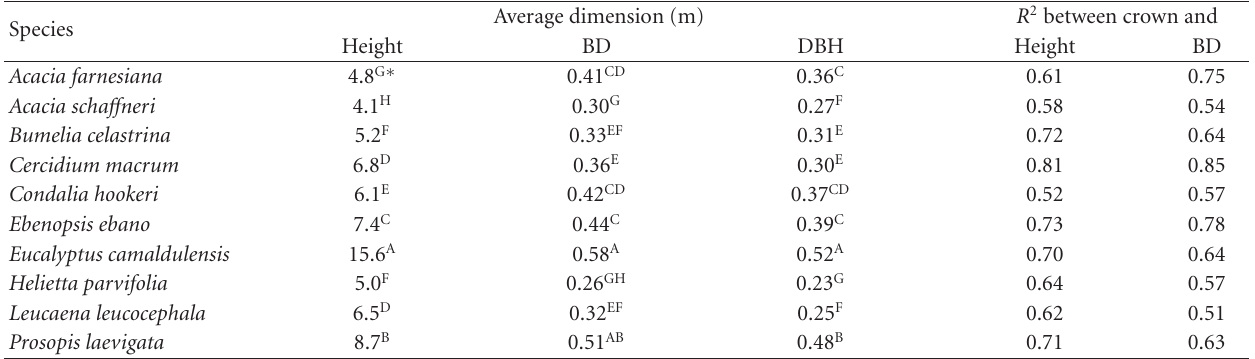
Table 2: Duncan’s multiple-range test (DMRT) for height, basal diameter (BD), and diameter at breast height (DBH) parameters. Coe ffi cient of determination ( R 2 ) was calculated between crown area and height and between crown area and basal diameter. Average dimension (m) R 2 between crown and Species